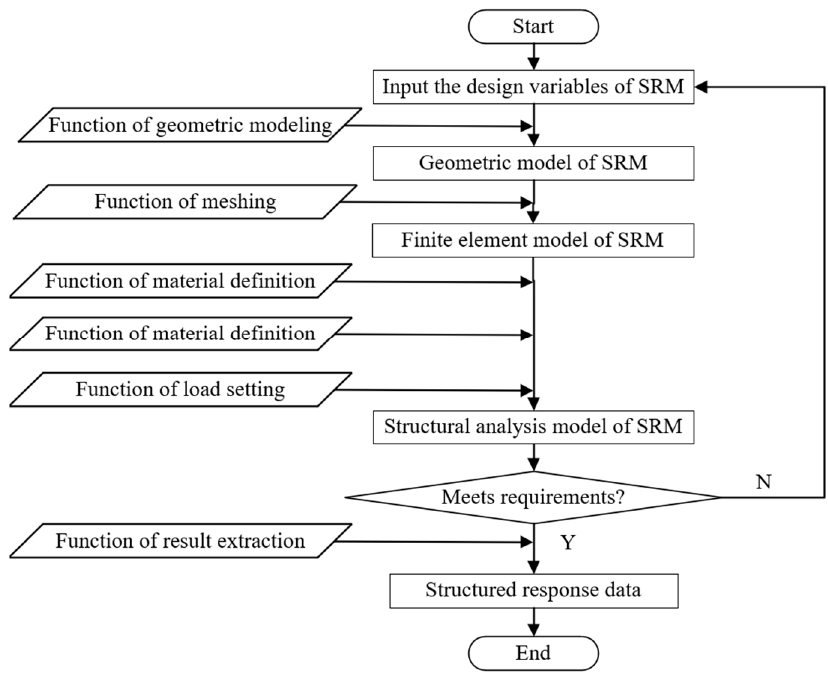
Figure 5. Flowchart for parametric modeling of SRM based on Python functions.